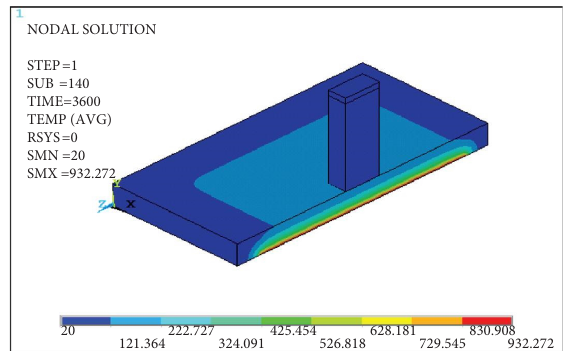
Figure 24: FEA temperature distributions after 3600sec fre exposure at the bottom of specimen S1